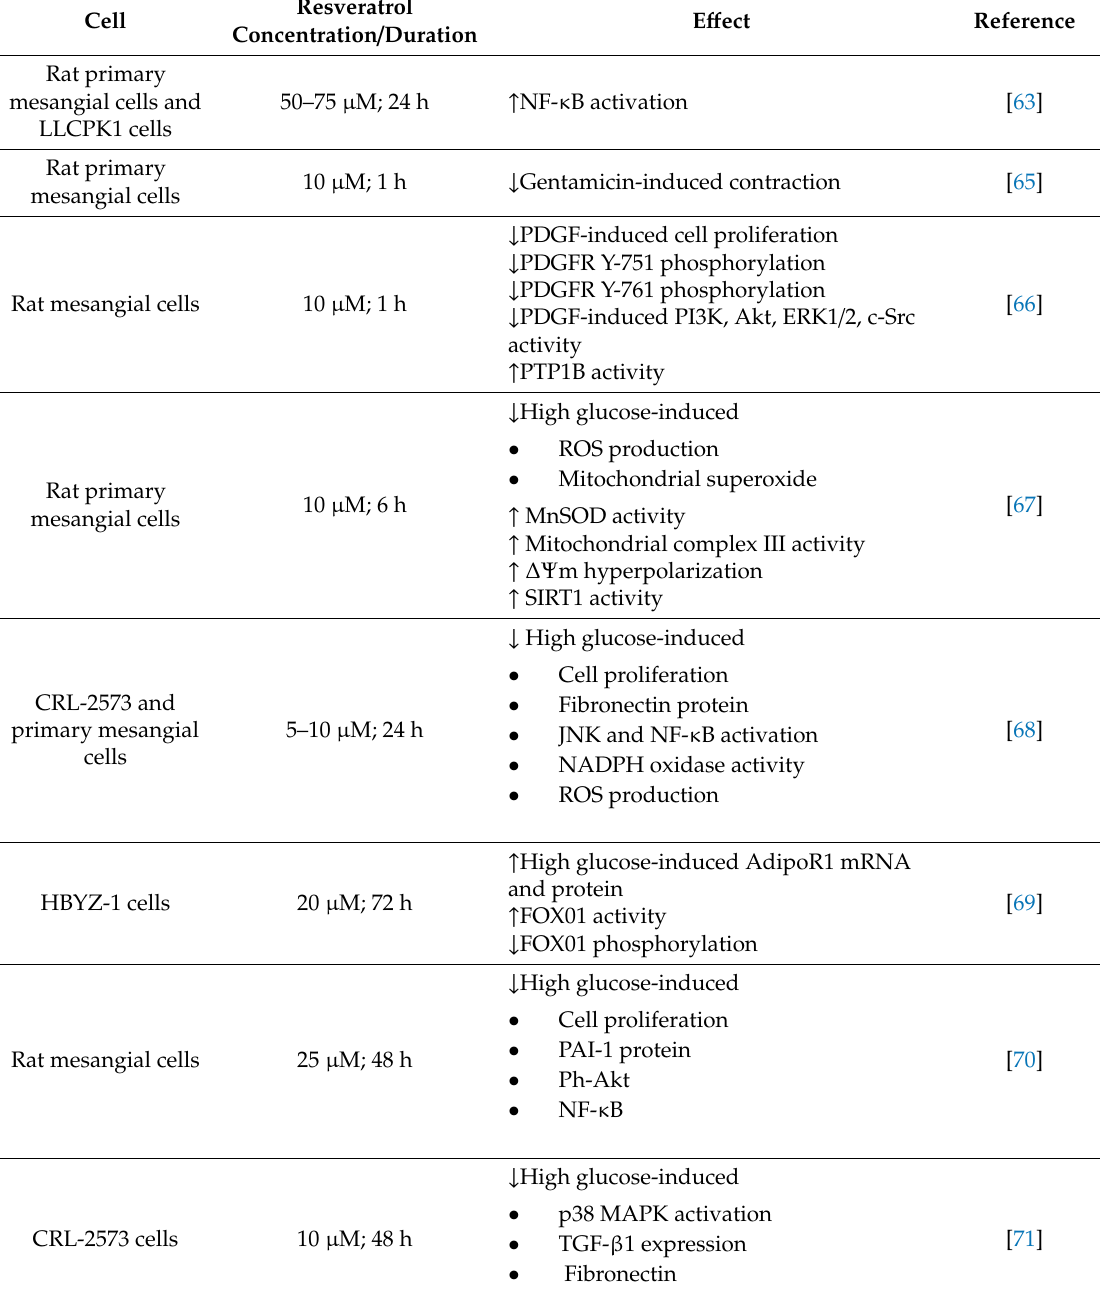
Table 1. E ff ects of resveratrol on kidney mesangial